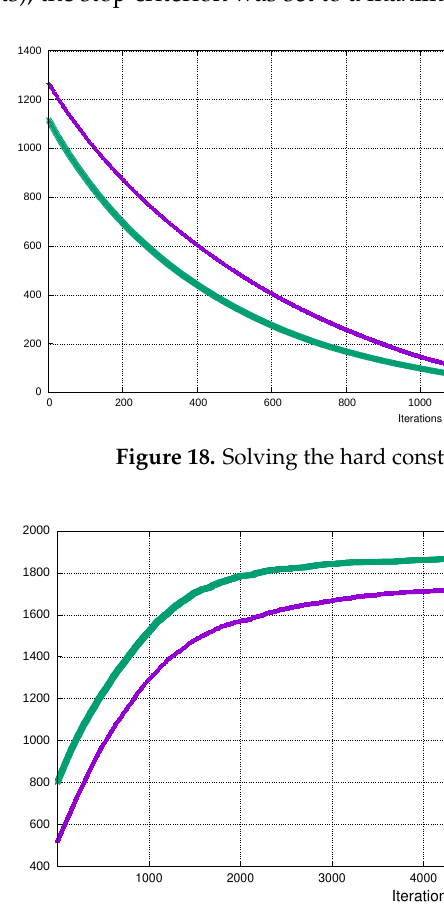
Figure 19. The satisfaction of soft constraints in the TTP